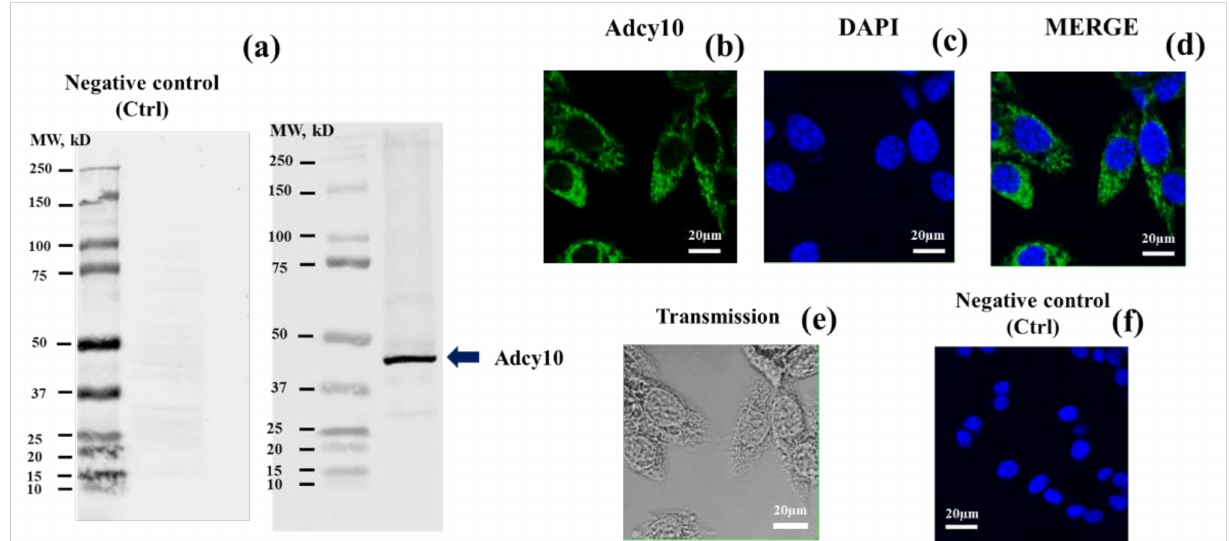
Figure 1. Soluble adenylyl cyclases (ADCY10) immunodetection in MLTC-1 cells. ( a ) Western-blot dentification of ADCY10 in MLTC-1. Cell lysates were resolved by SDS-PAGE, transferred to nitrocellulose membrane and then, probed with an anti-ADCY10 antibody. Loading the first lane of the well with Protein Marker (Precision Plus Protein Dual Color Standards). This marker has three reference bands that allow to monitor electrophoresis. When the gel is stained, 10 bands are